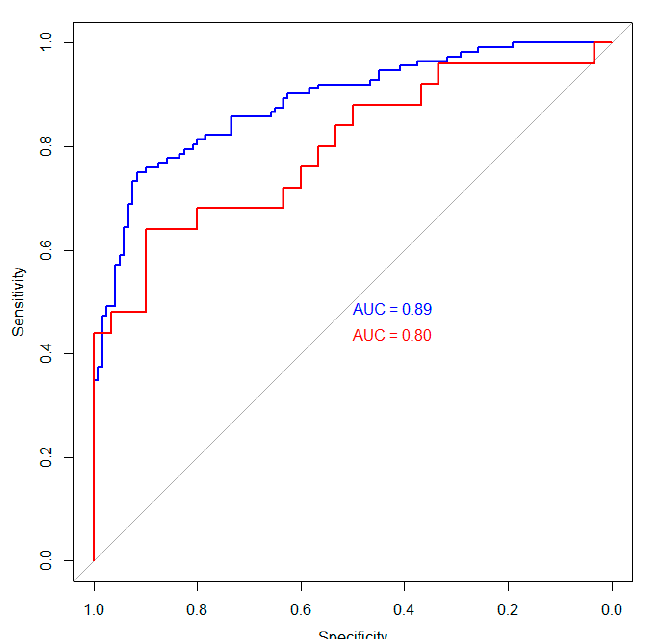
Figure 5. Visualization of the created artificial neural network. Receiver operating characteristic